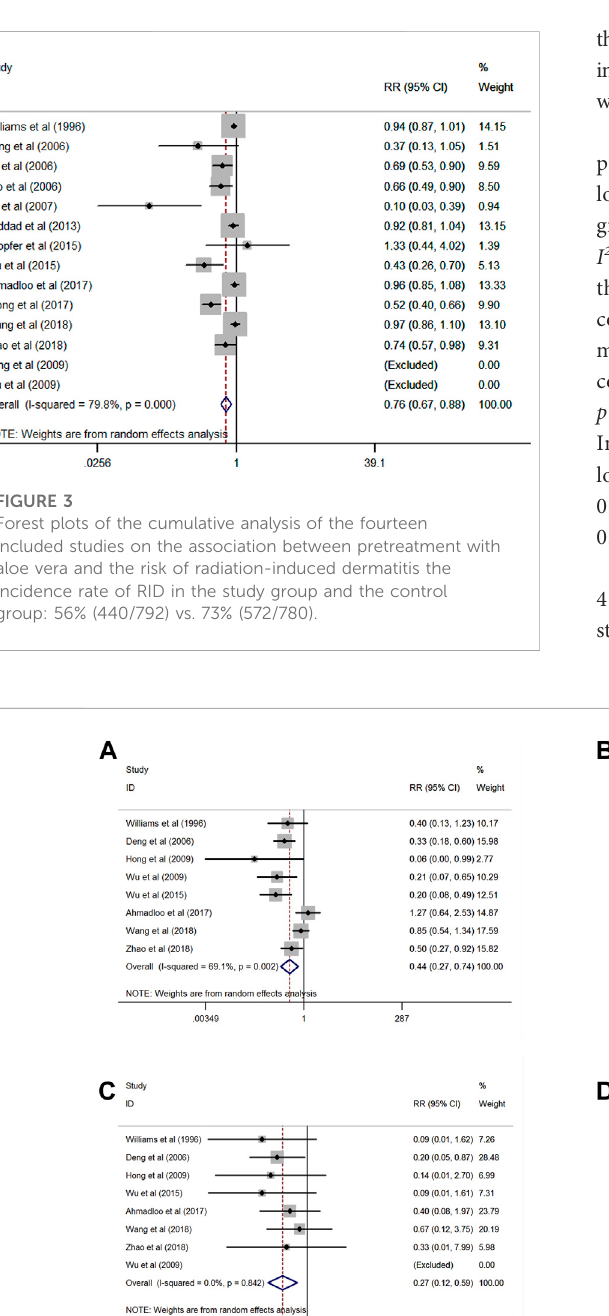
Figure 4D). This result indicated aloe vera exerted no protective effect against Grade 4 RID.